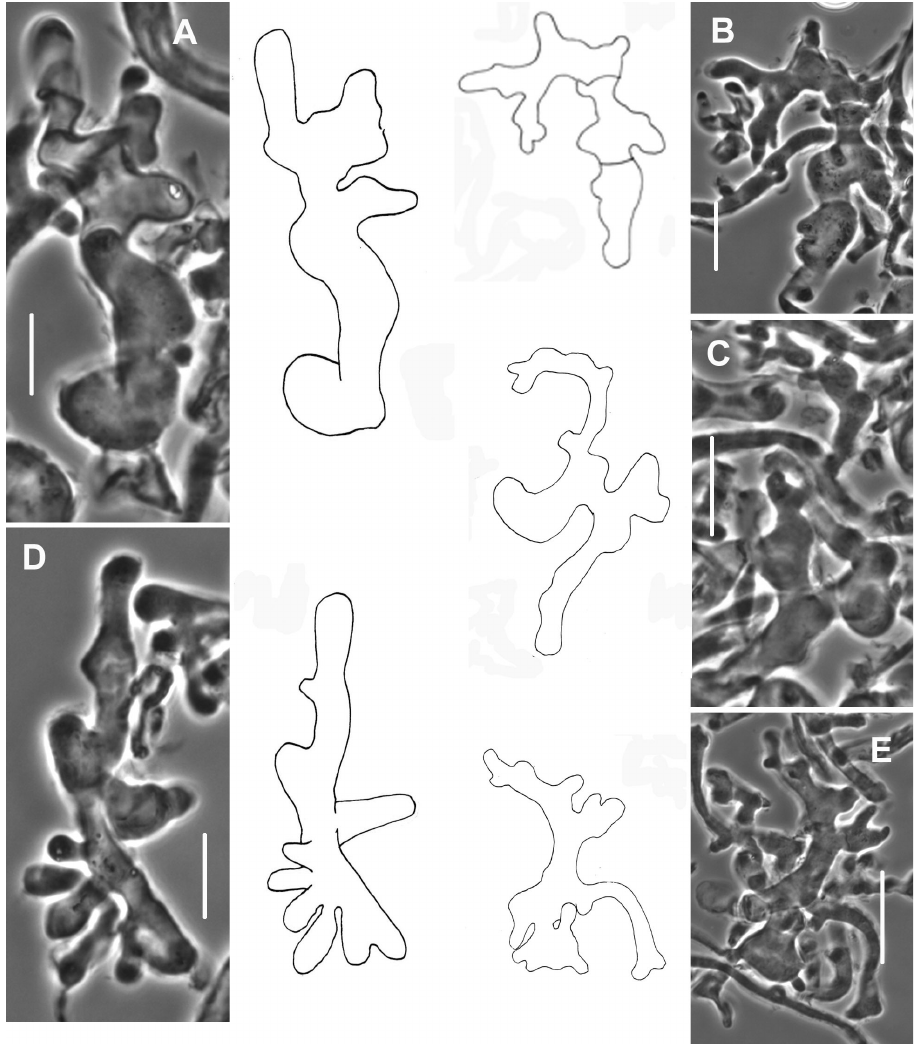
Figure 43. Mycetinis olidus . Free-form pileipellis structures. Outlines furnished to better interpret pho- tographs. Standard bars = 10 µm. DED 4529 (TENN